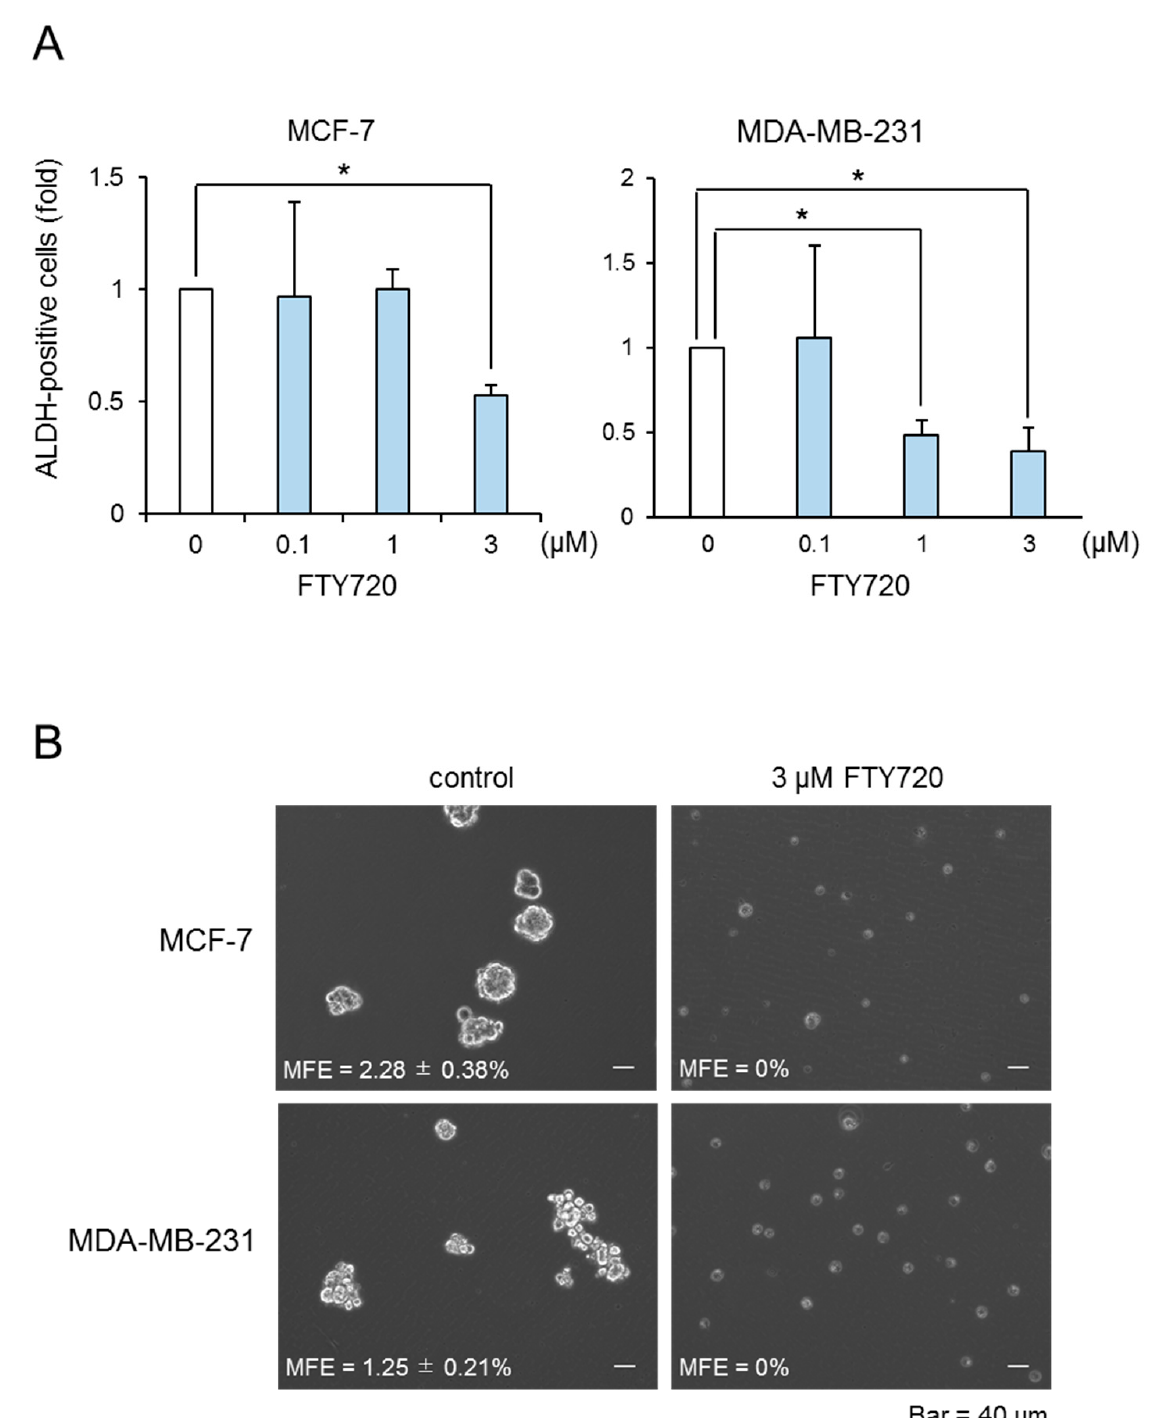
Figure 1. Effect of FTY720 on breast CSC proliferation. ( A ) After treatment with different concentration of FTY720 for 3 days, the ALDH-positive cells of MCF-7 cells ( left ) and MDA-MB-231 cells ( right ) were assessed using the ALDEFLUOR kit and flow cytometry. ( B ) Effect of FTY720 (3 µ M) on mammosphere-forming efficiency in MCF-7 and MDA-MB-231 cells. The number of mammospheres was microscopically counted and the percentage of mammosphere-forming cells was determined as mammosphere-forming efficiency (MFE; %). The scale bar indicates 40 µ m. Data represent mean ± s.d. ( n = 3). * p < 0.05.